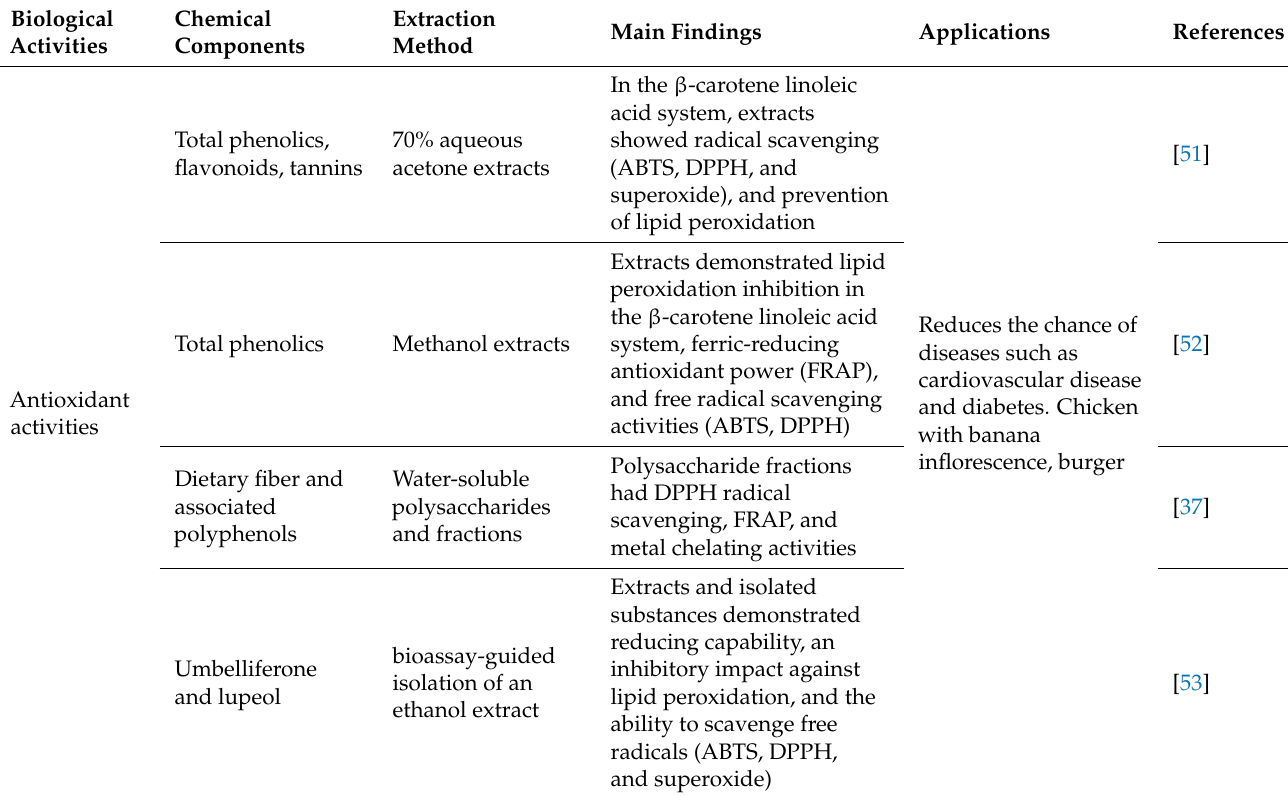
Table 2. Benefits of banana inflorescence and their